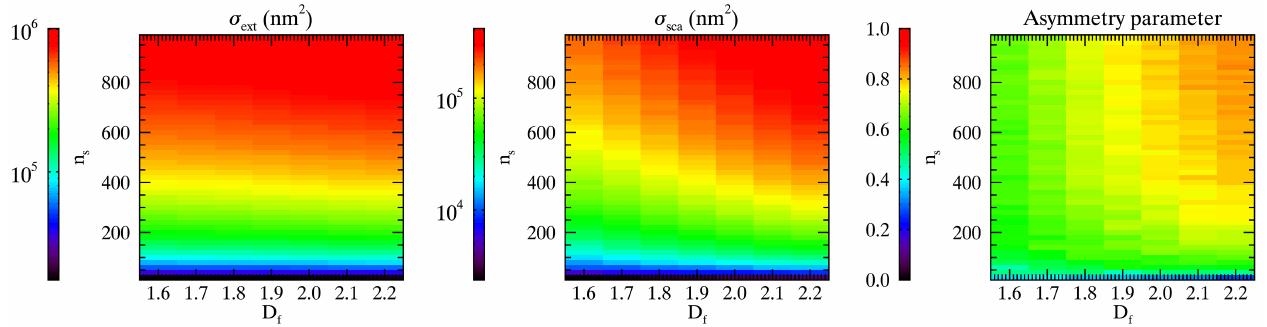
Figure 2. Extinction cross section, scattering cross section, and asymmetry parameter calculated using the MSTM code at λ = 550nm for a range of fractal dimensions and numbers of spherules.